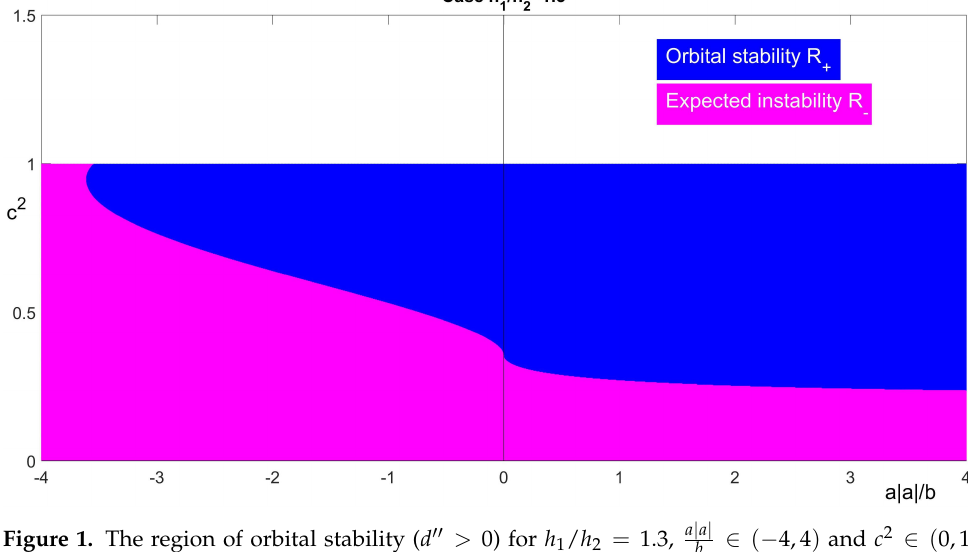
∈ ( − 4,4 ) and c 2 ∈ ( 0,1 ) : b